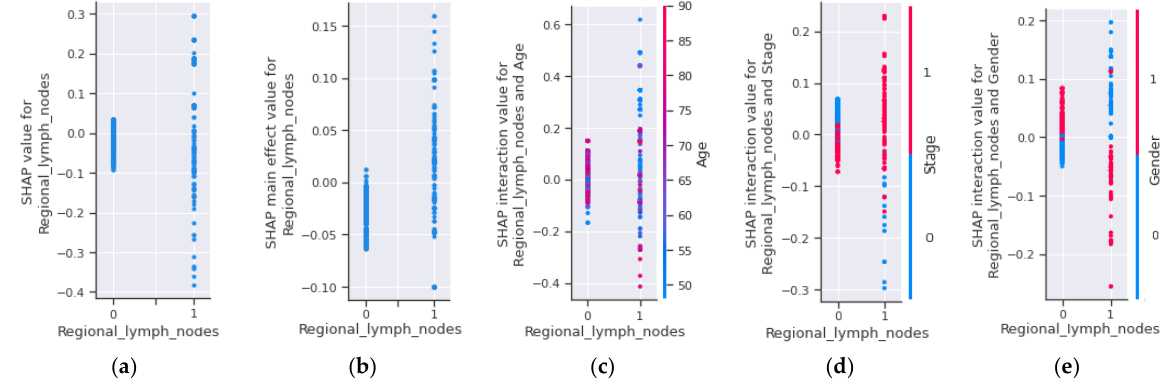
Figure 11. Dependence plots of SHAP interaction values between lymph and other important char- acteristics: ( a ) SHAP value of lymph; ( b ) SHAP main effect value of lymph; ( c ) SHAP interaction value between lymph and age; ( d ) SHAP interaction value between lymph and stage; and ( e ) SHAP interaction value between lymph and gender.